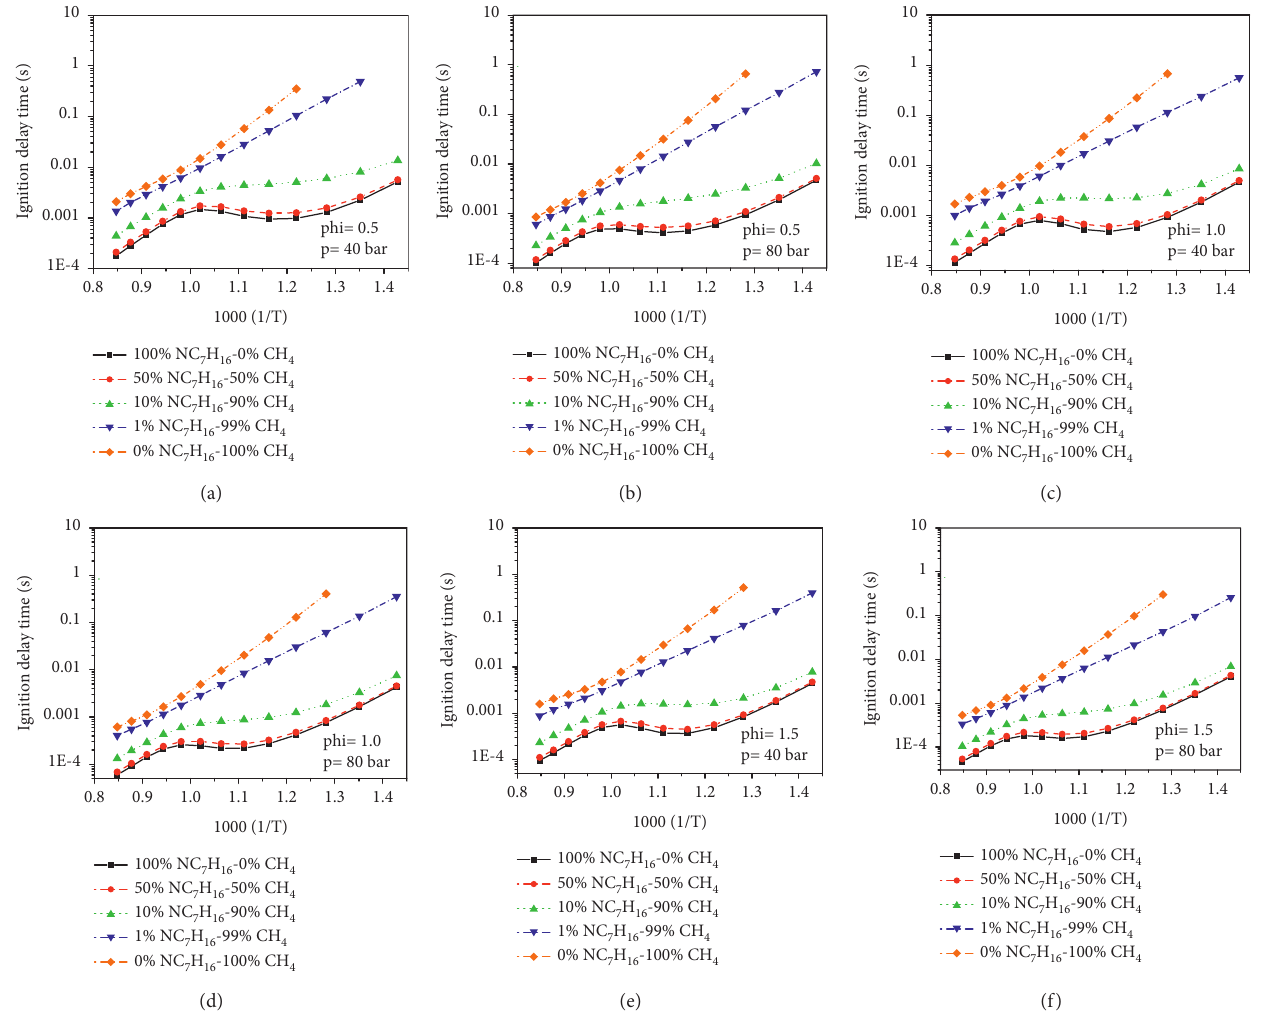
Figure 3: Ignition delay time of different methane/n-heptane mixing ratios at p � 40 bar, 80 bar, and different equivalence